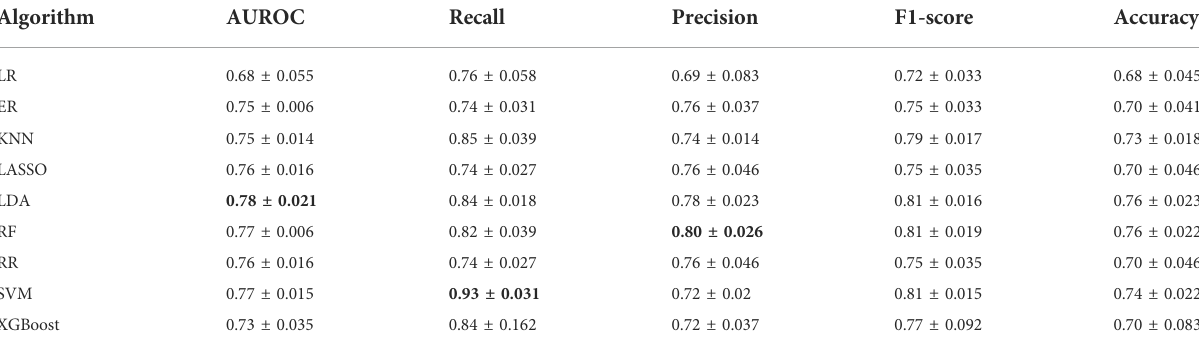
The SVM model with the tuned hyperparameters (Supplementary Table S2) performed best with respect to stabilize the validation error from the SVM model. Figures 3B,C